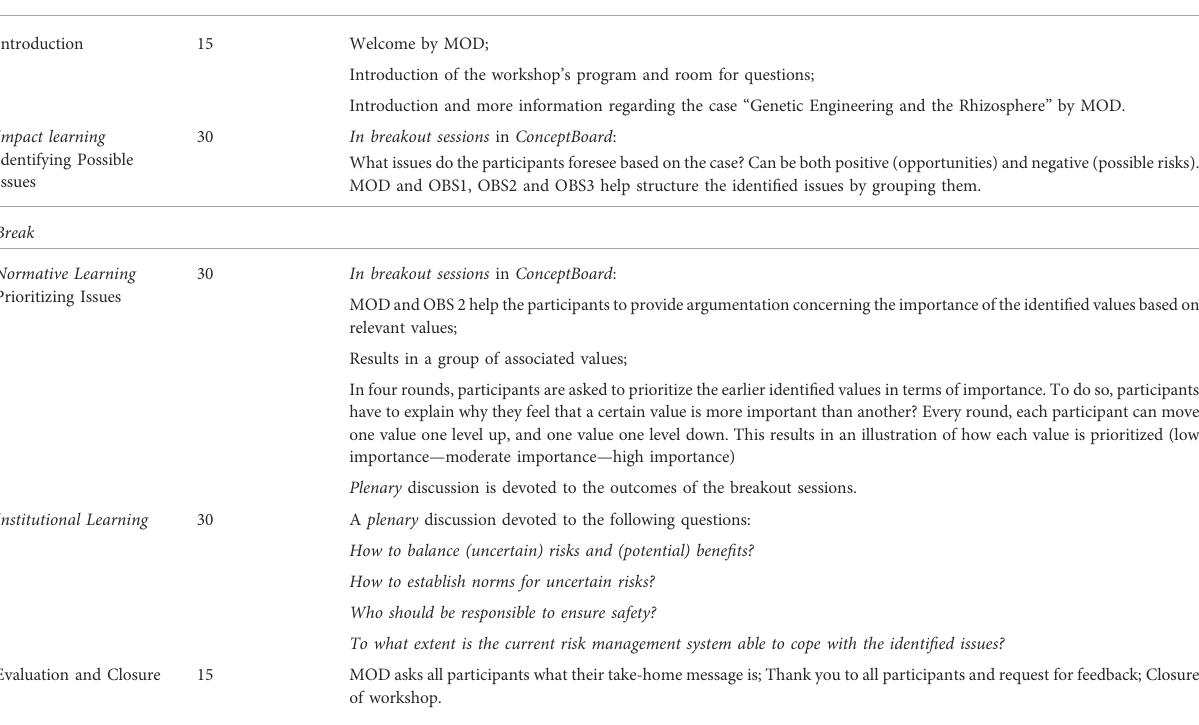
TABLE 1 Script for Workshops conducted in March and June 2021. MOD, Moderator of the workshop; OBS, Observant (x3); “ ConceptBoard ” is an online platform which was used as an interactive discussion tool during these workshops. Program part Approx. Time